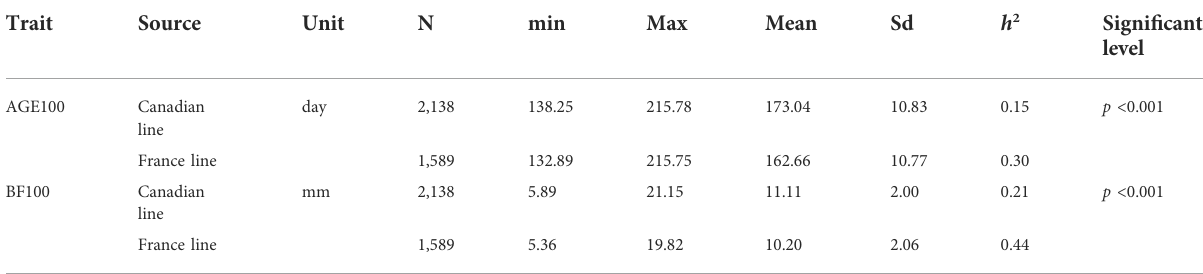
TABLE 1 Descriptive statistics of AGE100 and